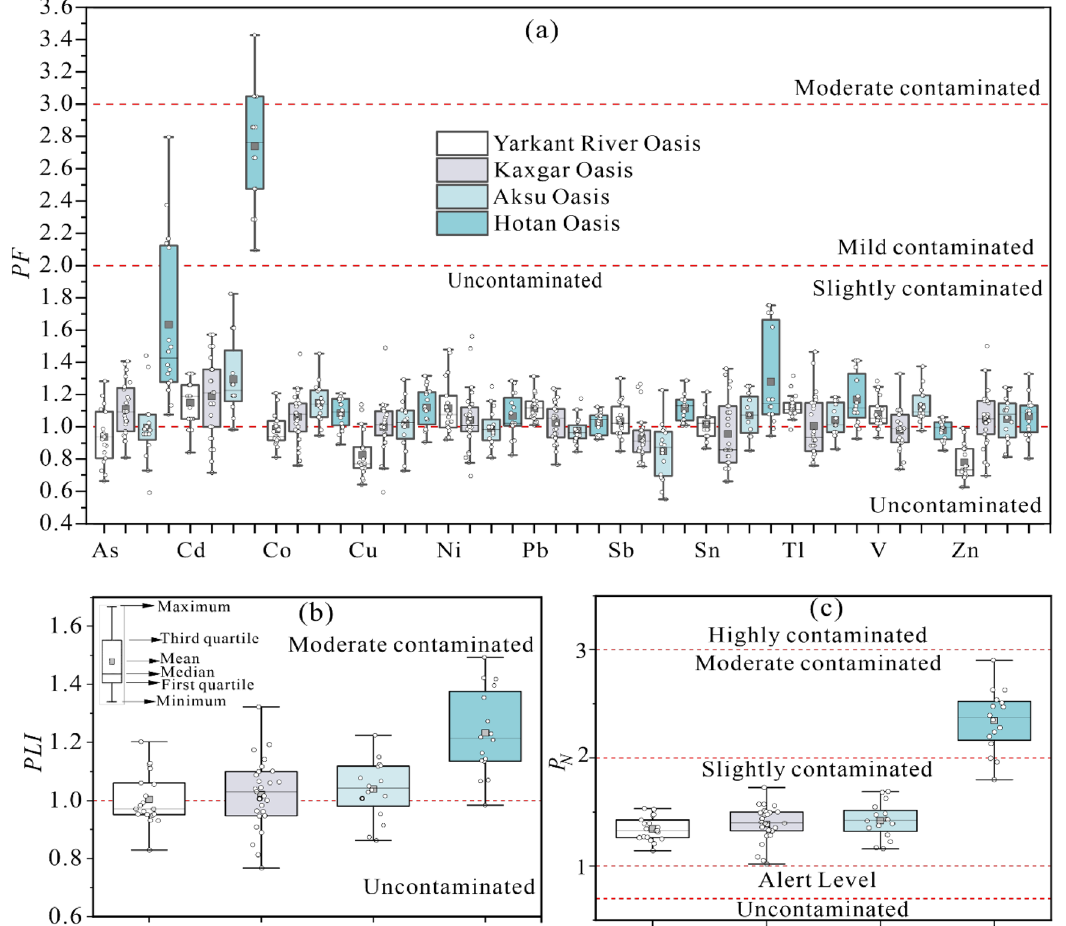
Figure 2. Box-whisker plots of PF ( a ), PLI ( b ) and P N ( c ) of PTEs in oasis agricultural